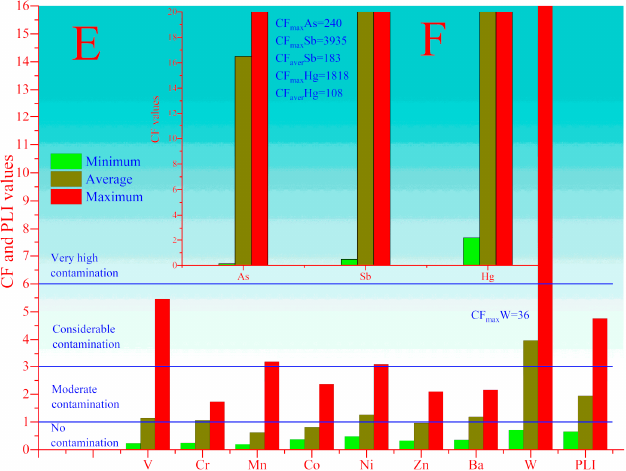
Figure 6. Values of CF and PLI of unexposed soil ( A ) and sediments ( B ), as well as soils ( C , D ) and sediments ( E , F ) related to anthropogenic impact.